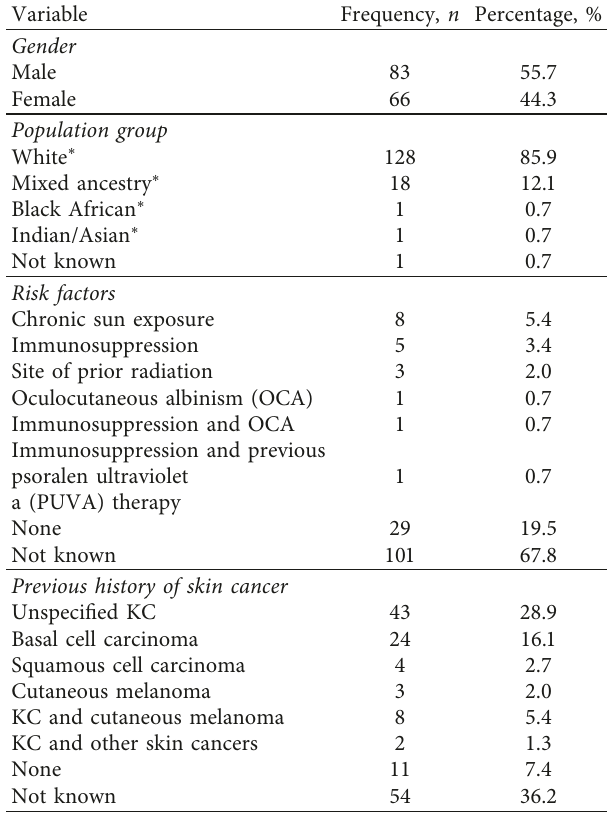
Table 1: Demographic and clinical characteristics of patients with BCC ( N �